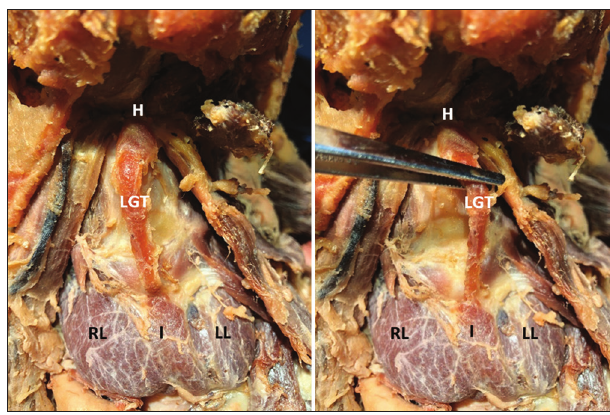
FIGURE 1. The levator glandulae thyroideae is a fibromuscular band or accessory muscle that originates from the isthmus of the thyroid gland and attaches to the body of the hyoid bone (hyopyramidalis (8,9)), as seen in these images. LGT: Levator Glandulae